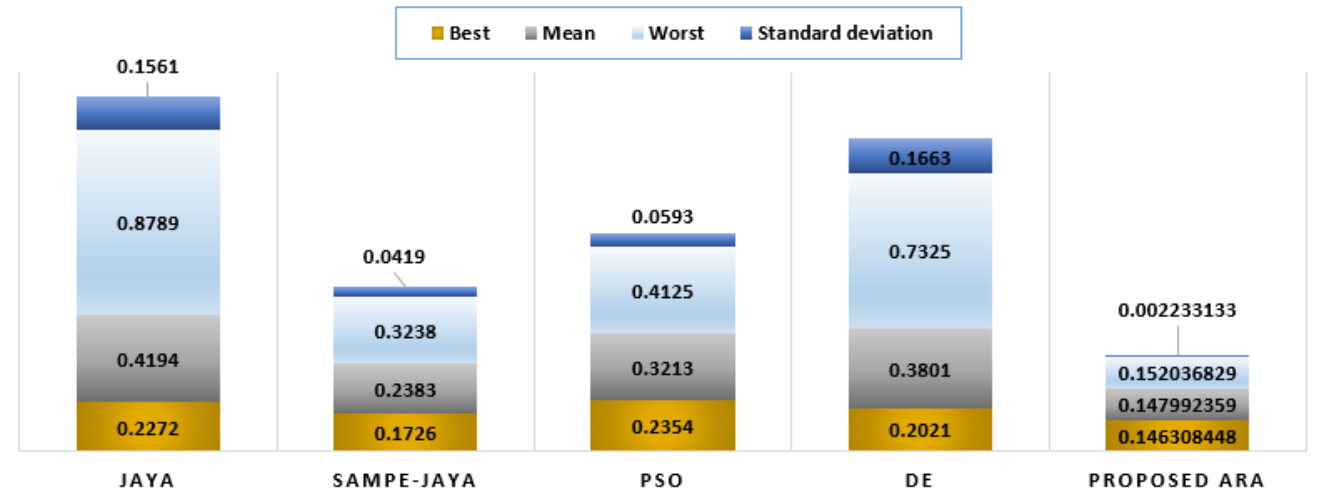
Figure 9. Statistical indices for SAMPE-JAYA, JAYA, DE, PSO and the proposed ARA under case study 3.